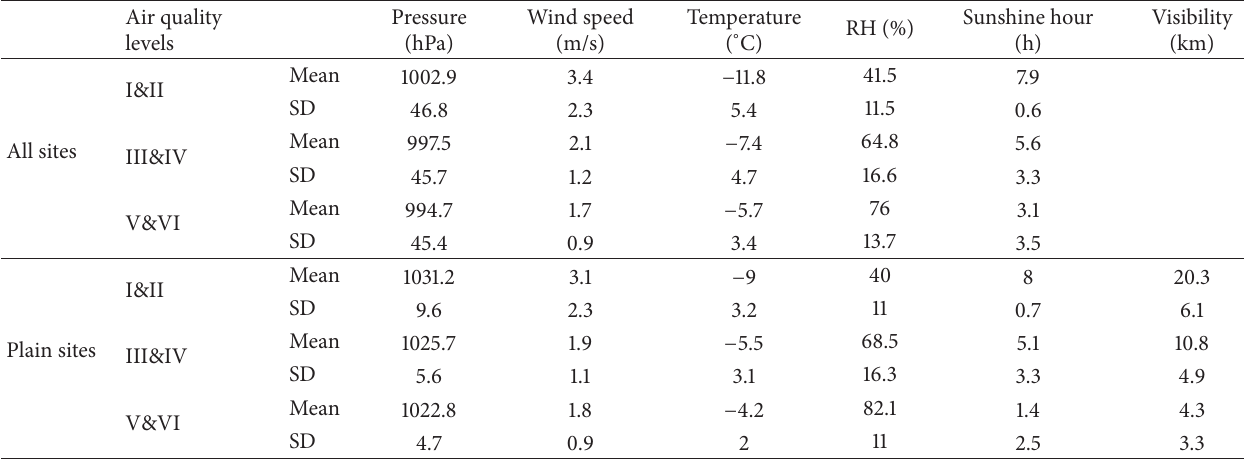
Figure 7: The distributions of the average surface RH (shaded) and wind field (black arrows) from NCEP/NCAR FNL reanalysis data for different periods in January 2013: (a) 1–31, (b) 10–14, and (c) 26–30. Red lines represent the orographic convergence line. Table 2: Summary of meteorological factors in January 2013 in different air quality levels over the BTH